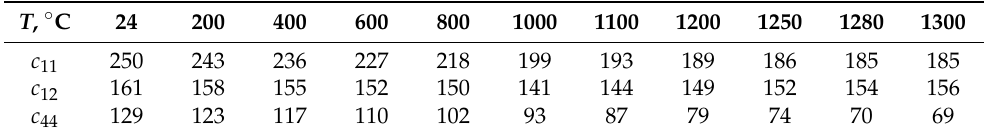
Table 2. Temperature dependence of elastic stiffnesses c ij of CMSX-4, GPa. T , ◦